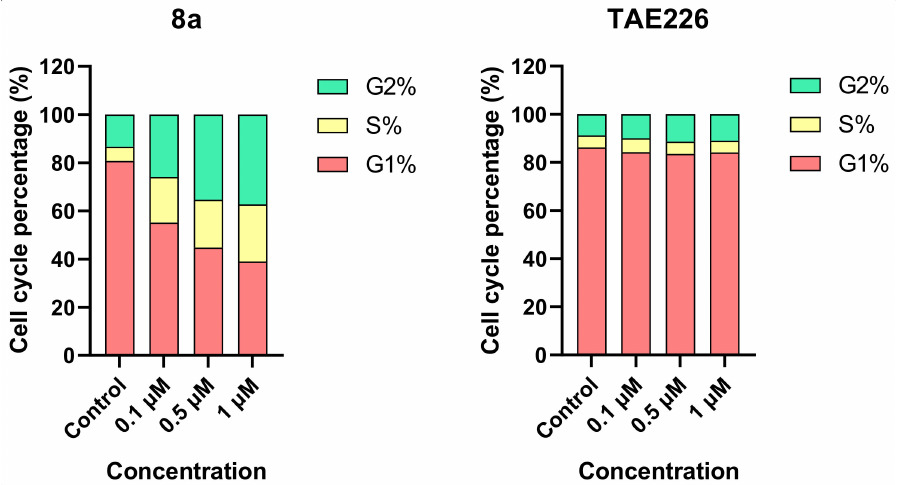
Figure 8. The cell cycle percentage of H1975 cells treated with 8a and